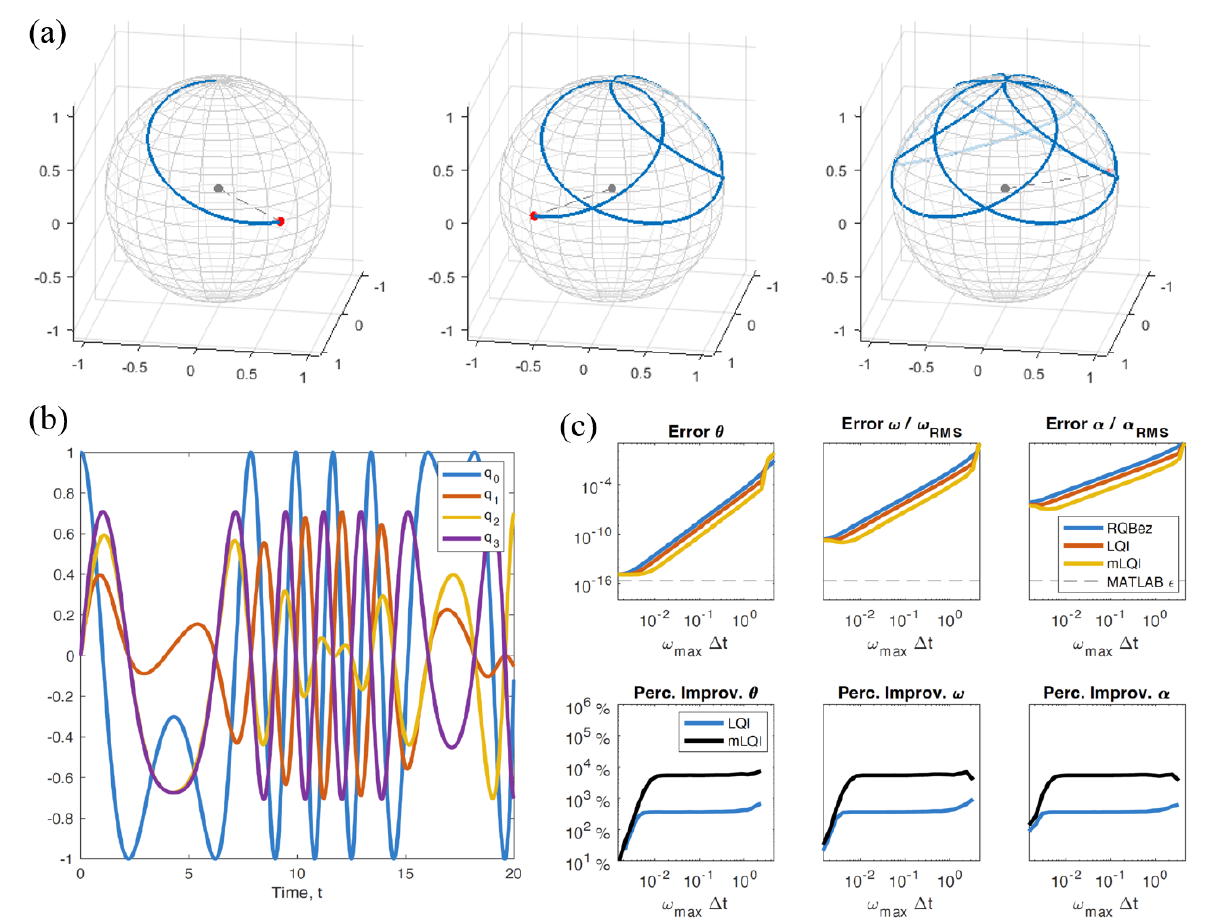
Figure 4. ( a ) The rotational motion of ˆ r 0 = ˆ z as a result of constant rotation in the quaternion angle as well as an oscillating unit vector. ( b ) What the quaternion themselves look like. Here, ω φ = 0.2 rad ω θ = ω 0 sin ( ω 0 t ) , and ω 0 = π rad . Here the combination of a constantly rotating angle and an s oscillating unit vector creates extremely varying elements. ( c ) Error in the angle θ , the magnitude of angular momentum (cid:107) (cid:126) ω (cid:107) , and magnitude of the angular acceleration α , both in absolute magnitude and relative to RQBez. For the majority of keyframe spacings, LQI and mLQI outperform RQBez by over two orders and four orders of magnitude, respectively. For small enough keyframe spacings, the methods